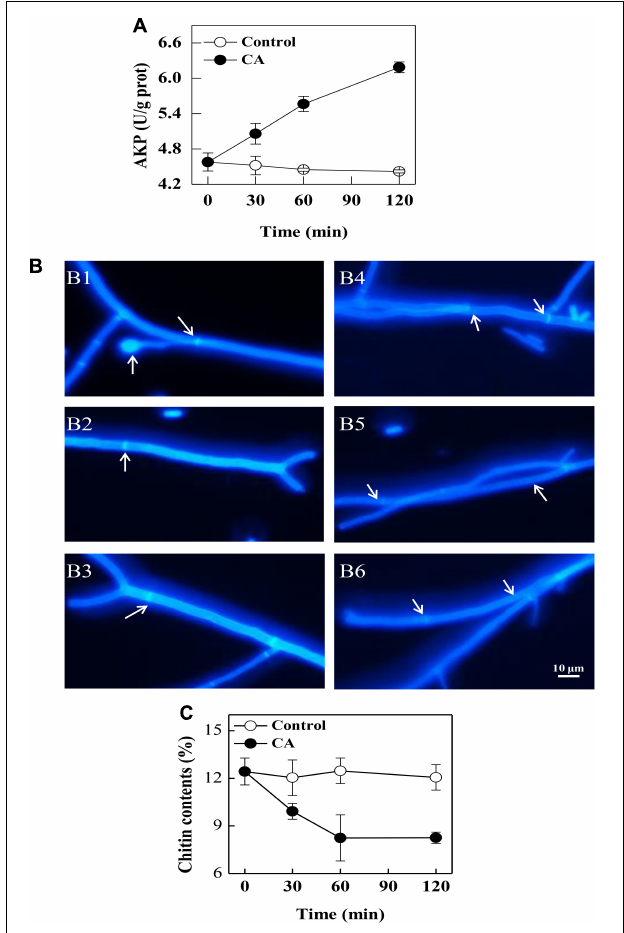
FIGURE 4 | The effects of CA on the cell walls of G. citri-aurantii . (A) The extracellular AKP activity of G. citri-aurantii ; (B) G. citri-aurantii treated with the 1/2MIC CA observed under a fluorescence microscopy after staining with calcofluor white stain ( × 100 magnification): (B1–B3) control group treated for 30, 60, and 120 min, respectively; (B4–B6) 1/2MIC CA group treated for 30, 60, and 120 min, respectively. (C) The chitin content of G. citri-aurantii . The data presented are the means of pooled data. Error bars indicate the SDs of the means ( n =